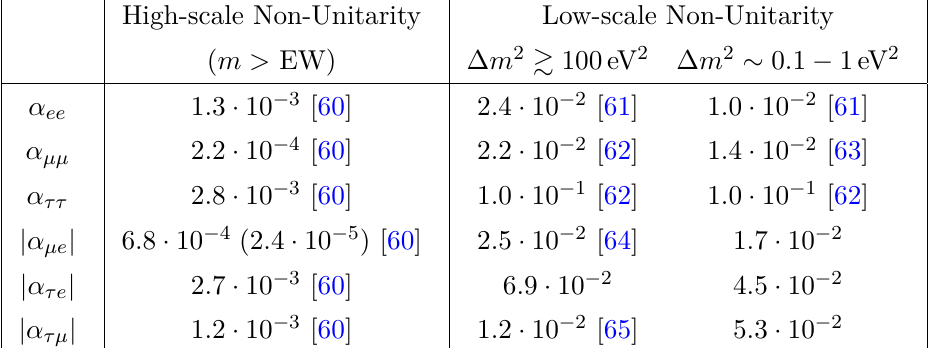
Table 1 . Upper bounds on the Non-Unitarity (NU) framework using the α parametrization, extracted from ref. [46]. The constraints are shown at 2 σ and 95% CL (1 d.o.f.) for NU stemming from very heavy scales and low scale physics (averaged-out light sterile neutrinos) respectively. The value quoted in parenthesis for the α µe element corresponds to the bound obtained from µ → eγ . The limits for the off-diagonal parameters without a reference are derived indirectly from bounds √ on the diagonal parameters via | α αβ | ≤ 2 α αα α ββ . See [46] for further